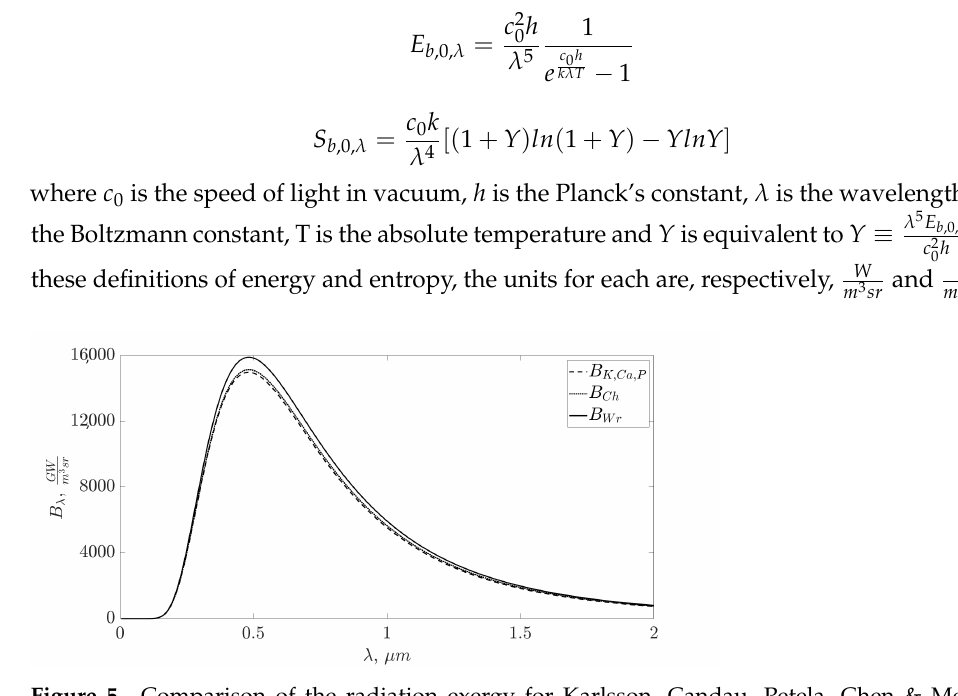
Figure 5. Comparison of the radiation exergy for Karlsson, Candau, Petela, Chen & Mo and Wright et al. considering T = 6000K and T 0 =